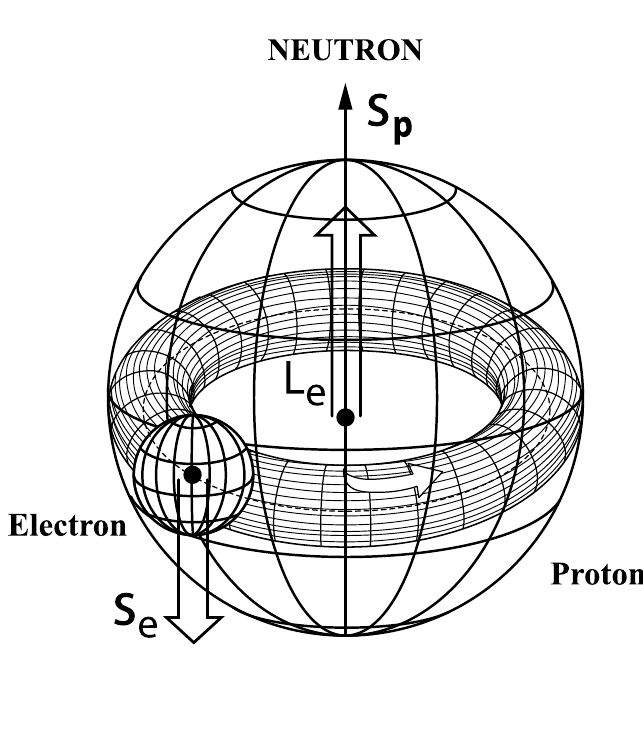
Figure 11: A conceptual rendering of the structure of the neutron as “compressed“ hy- drogen atoms in the core of stars according to H. Rutherford [40]. When the proton is represented as an extended particle, there is the emergence of a constrained orbital mo- tion of the electron inside the proton verifying the isodeterminism of Lemma 3.7, which allows the first known exact representation of all the characteristics of the neutron at the nonrelativistic [42] and relativistic [36] levels without need for the neutrino hypothesis.